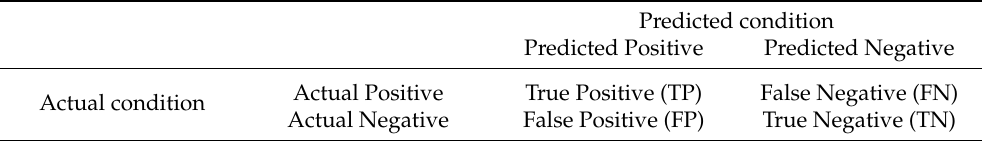
Table 5. Confusion matrix for binary classification.